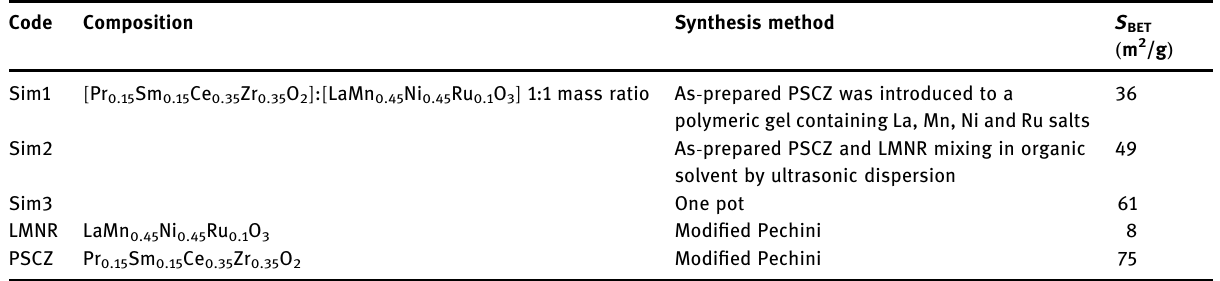
Table 1: Sample ’ s composition, synthesis methods and speci fi c surface area